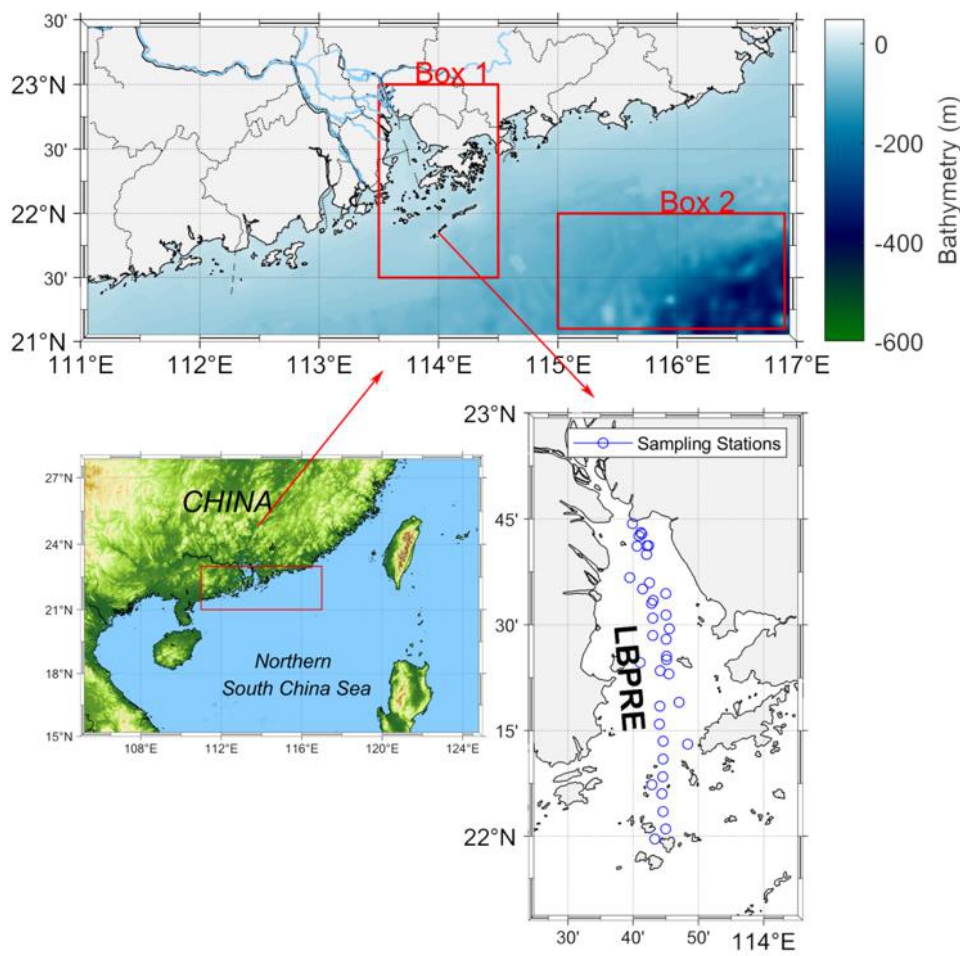
Figure 1. Study area and location of sampling